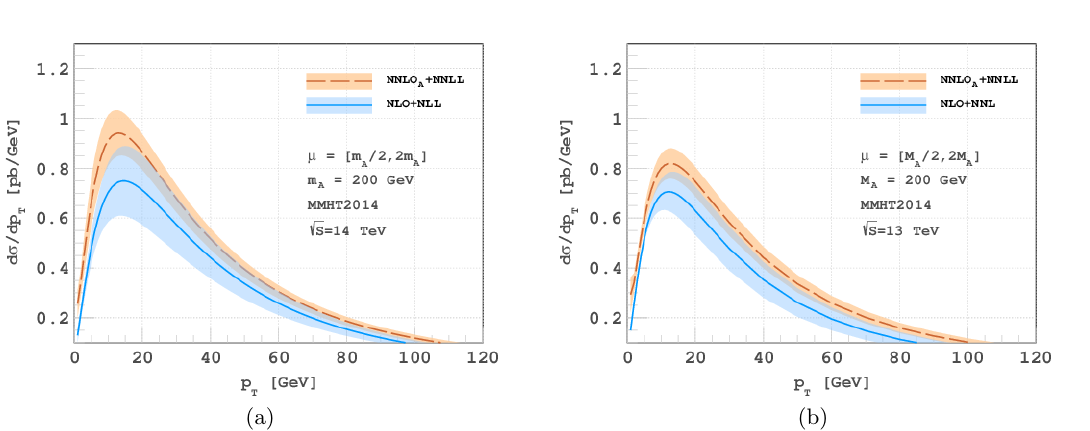
Figure 3 . (cid:22) R and (cid:22) F variation at NLO+NLL and NNLO A +NNLL for (a) 14 TeV and (b) 13 TeV.